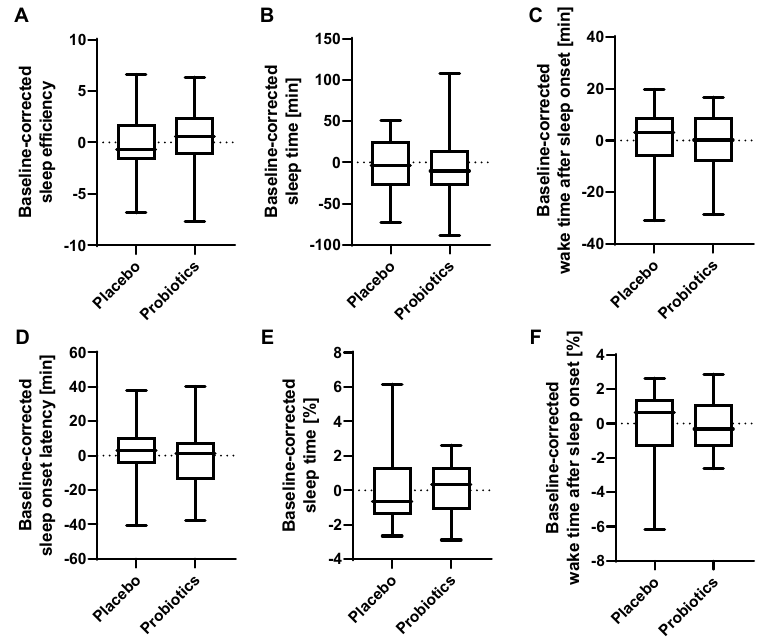
Figure 6. Effect of probiotic intervention on Actigraphy sleep measurements. Baseline-corrected ( A ) sleep efficiency (total sleep time/time in bed), ( B ) absolute sleep time, ( C ) absolute wake time after sleep onset, ( D ) sleep onset latency, ( E ) relative sleep time, ( F ) relative wake time after sleep onset. Line presents median, box presents 25th and 75th percentile, whiskers present minimum and max- imum.